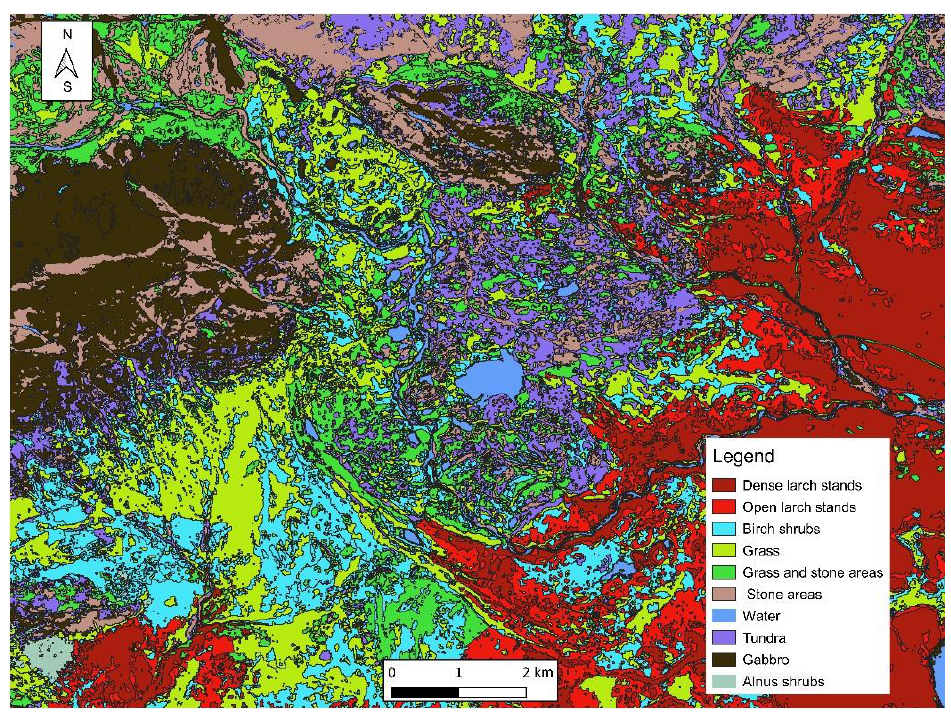
Figure 6. Landscape map of Mt. Chernaya and southern part of Rai – Iz range created with the use of satellite images.